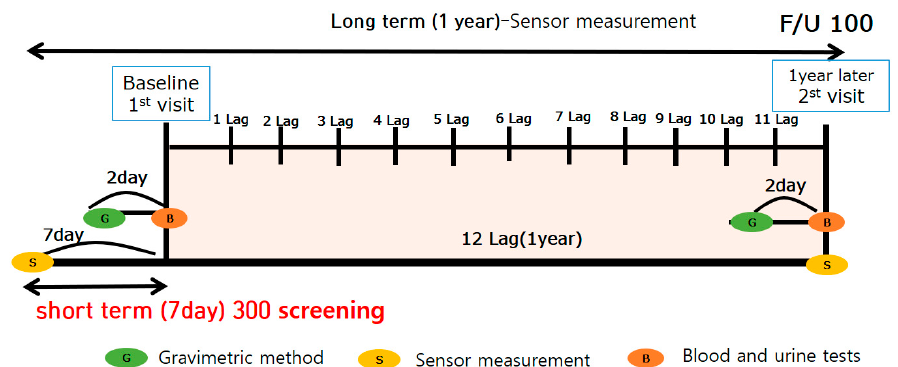
Figure 2. Schematic diagram of the study period.